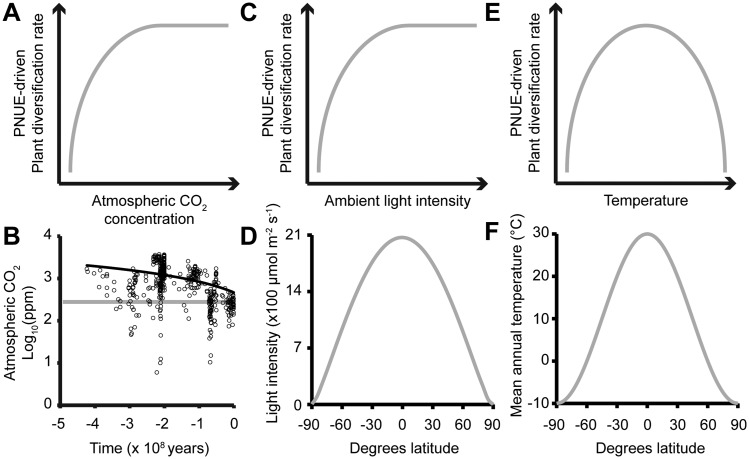
Photosynthetic nitrogen use efficiency (PNUE) modulates plant diversification. (A) Cartoon depicting the proposed relationship between PNUE-driven plant diversification and atmospheric CO2 concentration. (B) Changes in atmospheric CO2 concentration (ppm = parts per million) over the last 500 My, least squares linear fit shown as solid black line. Gray horizontal line indicates preindustrial CO2 levels (278 ppm) adapted from Foster et al. (2017). (C) Cartoon depicting the relationship between PNUE and light intensity. (D) The photon flux density on the surface of the earth at 0° longitude at noon on the vernal equinox. (E) Cartoon depicting the proposed relationship between PNUE-driven plant diversification and ambient temperature. (F) The average (contemporary) annual temperature at the surface of the earth (Randel et al. 2004).